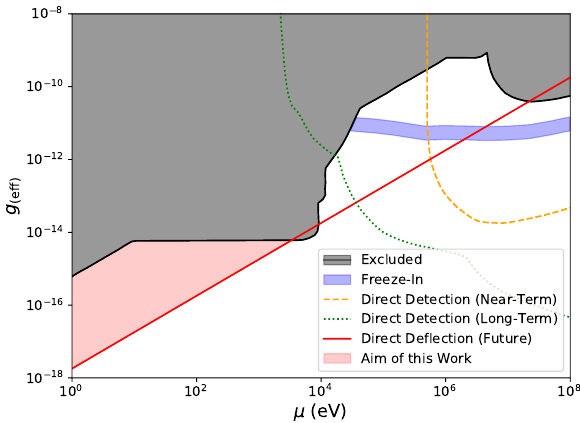
Figure 1 . A summary of millicharged dark matter parameter space in the 1 eV to 100 MeV mass range, showing previously excluded regions as well as the projected sensitivities of future direct deflection [10] and direct detection experiments, with the latter loosely divided into near-term (e.g. [8, 9]) and long-term (e.g. [11, 12]) projects. Also shown is the parameter region motivated